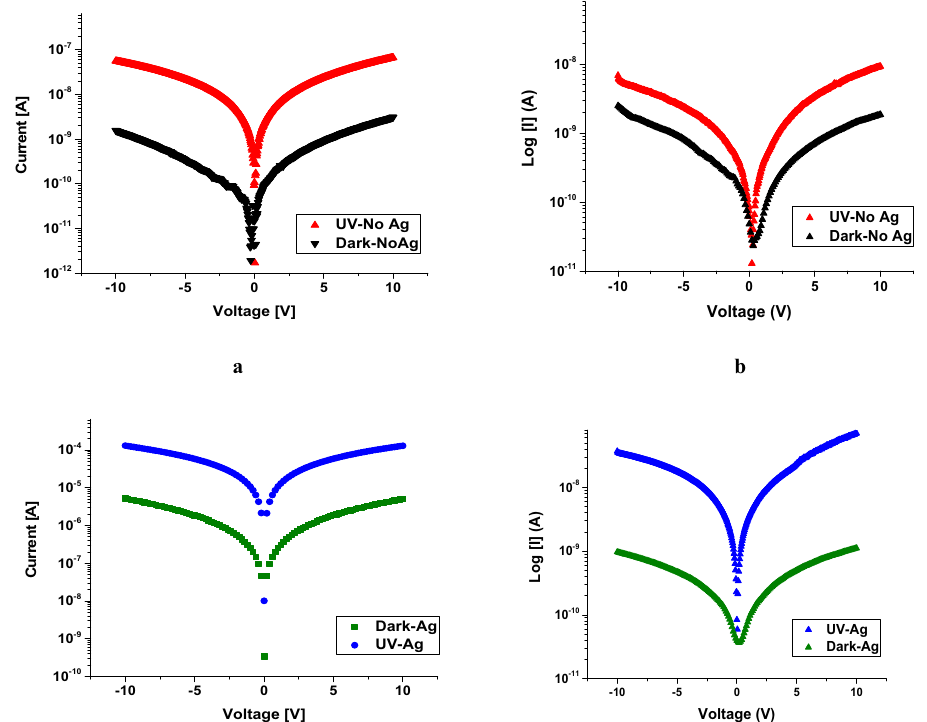
Figure 12. Semi-logarithmic plots of current density for Au/β-Ga 2 O 3 /Au MSM without and with Ag catalyst versus applied voltage characteristics at 10 V without and with UV illumination. ( a , c ) with sputtered Au metal contacts ( b , d ) with mesh Au metal contacts.